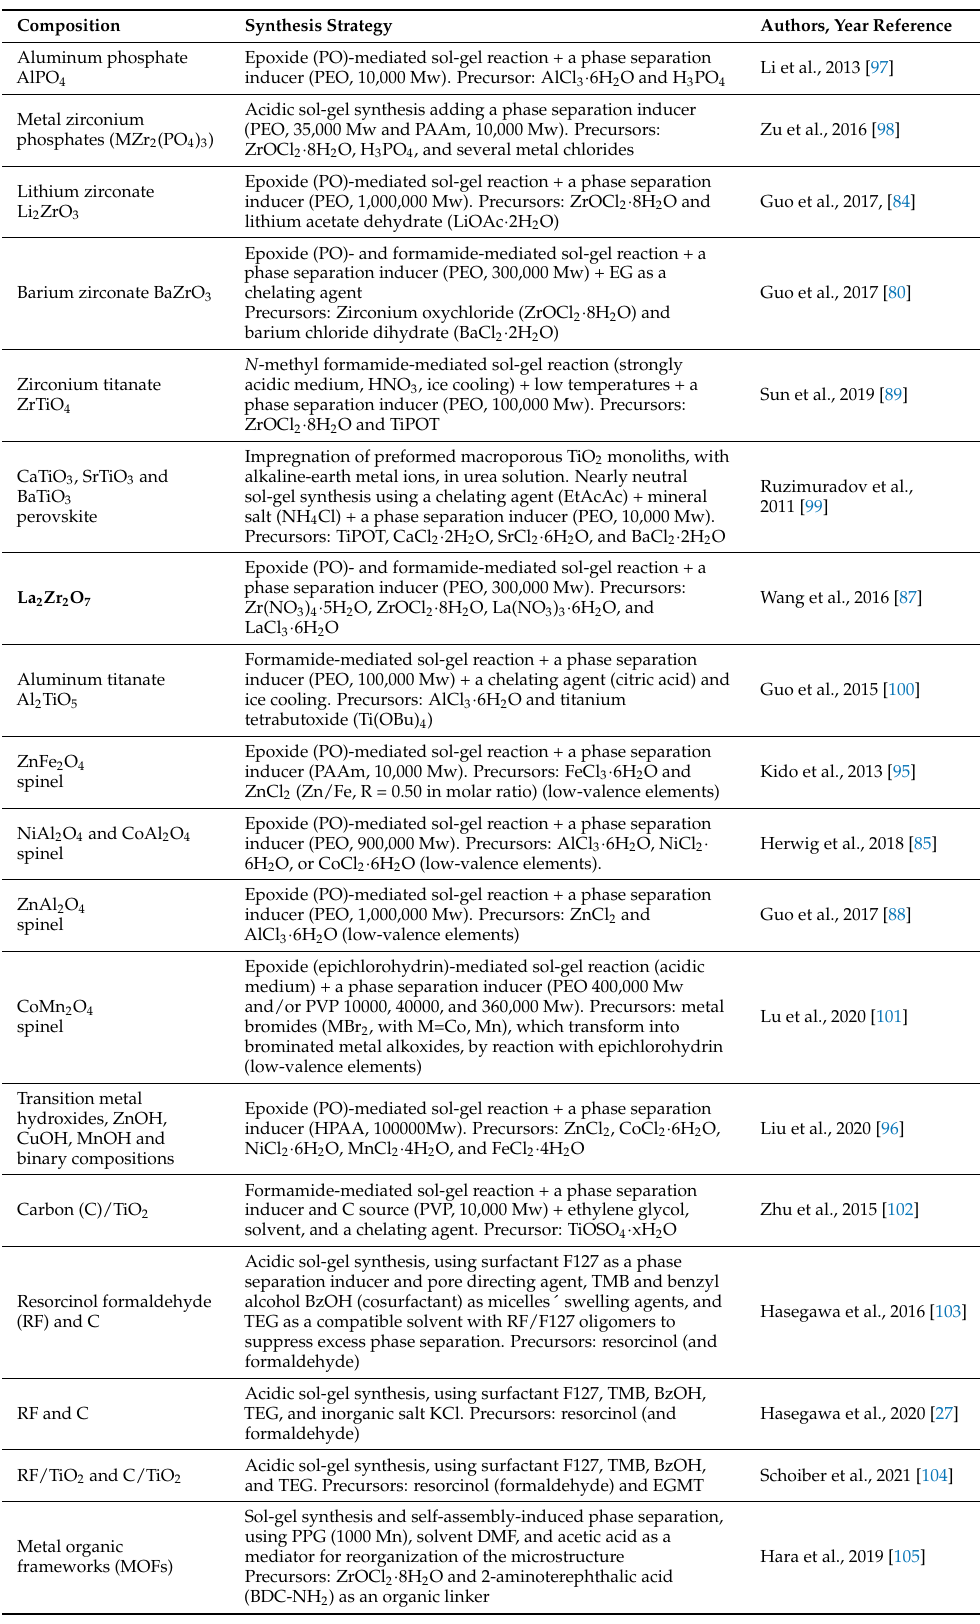
Table 4. Specific examples of synthesis strategies for the achievement of non-siliceous multi-oxide and non-oxide porous monoliths, prepared via sol-gel/phase separation